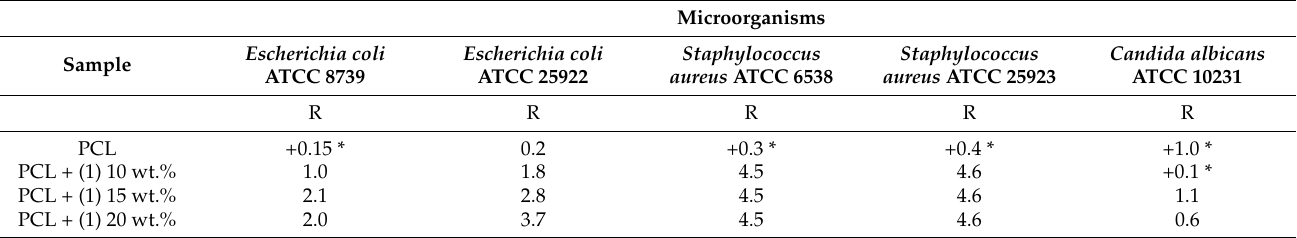
Table 1. Reduction index of microbial growth.